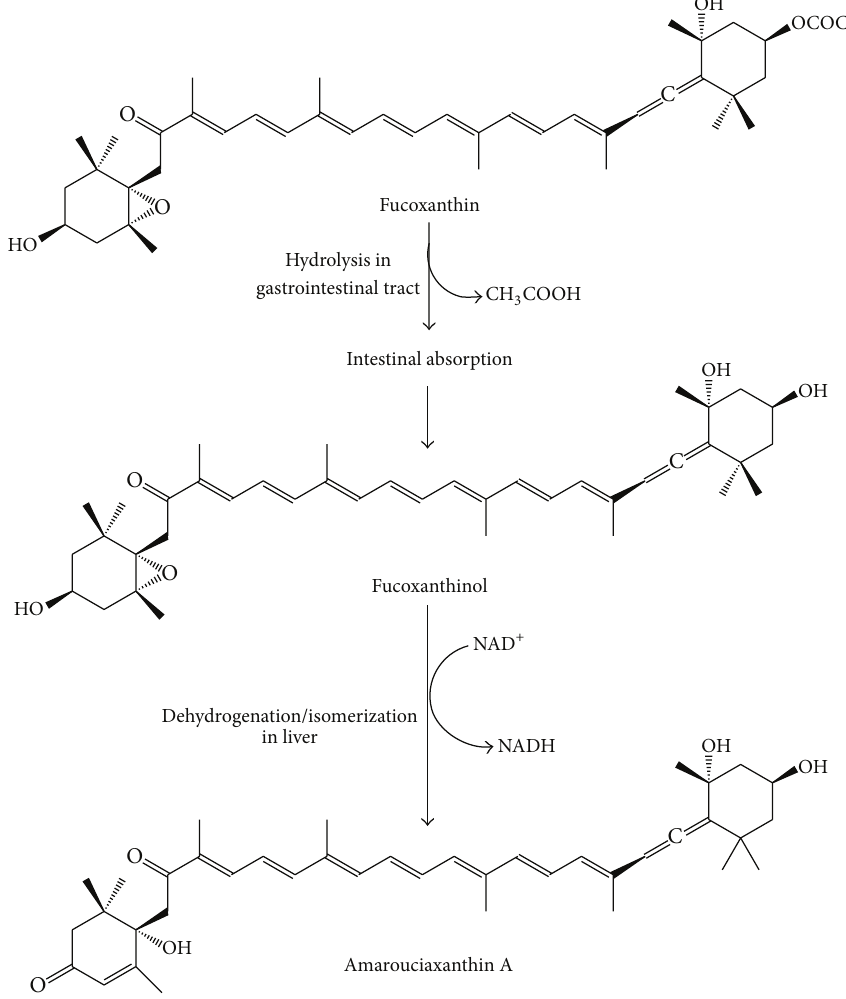
Figure 2: Proposed metabolic pathway of dietary fucoxanthin in